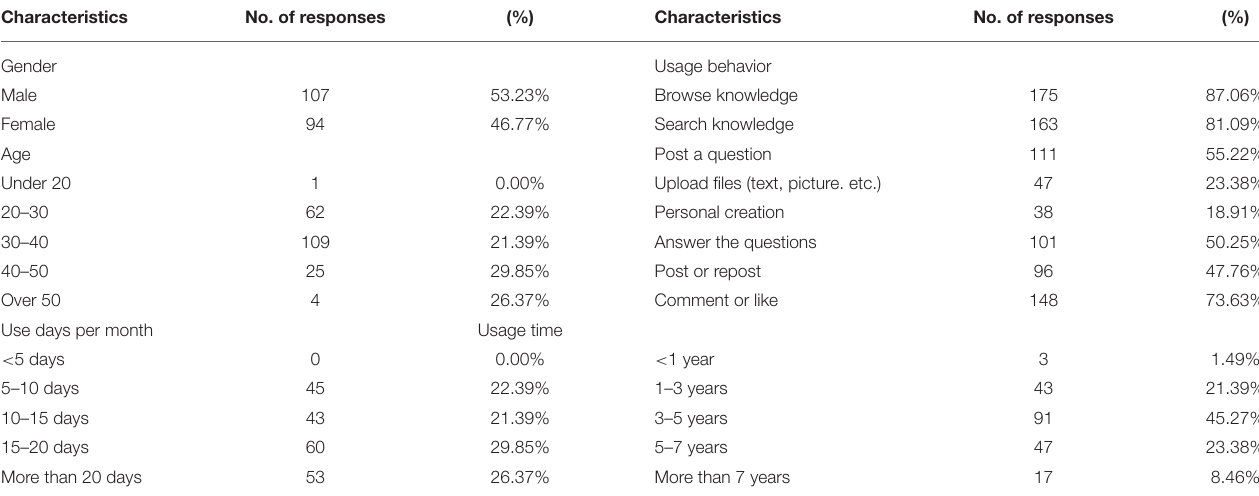
TABLE 1 | The basic characteristics of respondents.